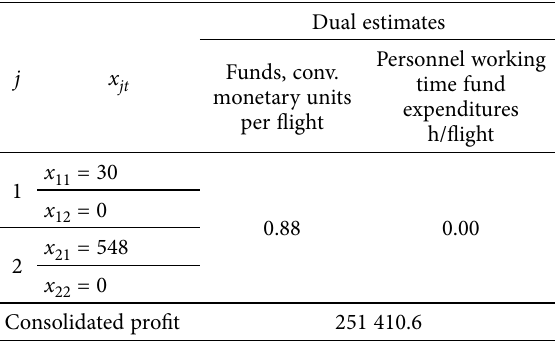
Table 5. The results of model experimental computations (5)–(9)